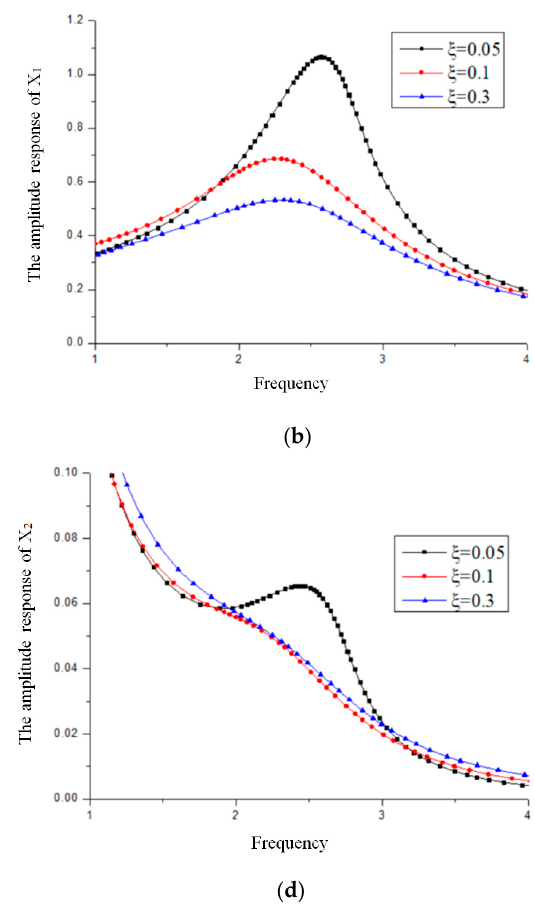
Figure 5. Amplitude – frequency characteristic curve of the isolation structure under different control parameters ( ( a , b ) Amplitude – frequency characteristic curve of the substructure; ( c , d ) Amplitude – frequency characteristic curve of the superstructure; ( e , f ) Amplitude – frequency characteristic curve of the hysteretic element.